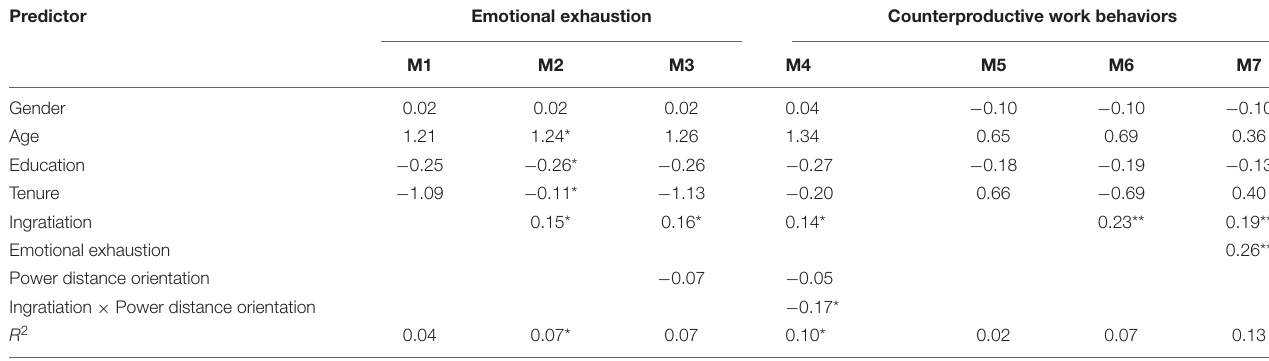
TABLE 3 | Regression analyses for hypothesis testing.